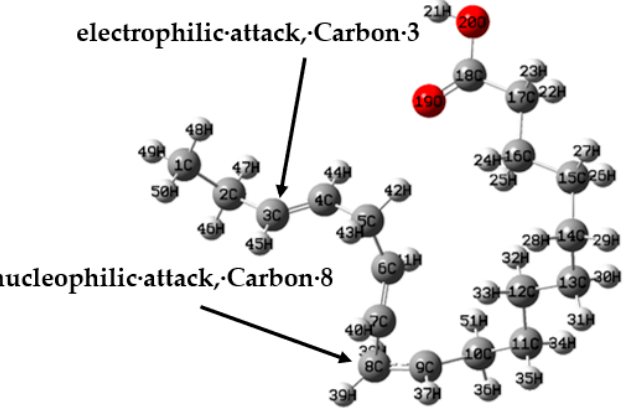
Figure 15. The nucleophilic and electrophilic attack in the protonated α -linoleic acid molecule using the Fukui function. Table 6. Calculated quantum chemical parameters for the protonated α -linolenic acid molecule.